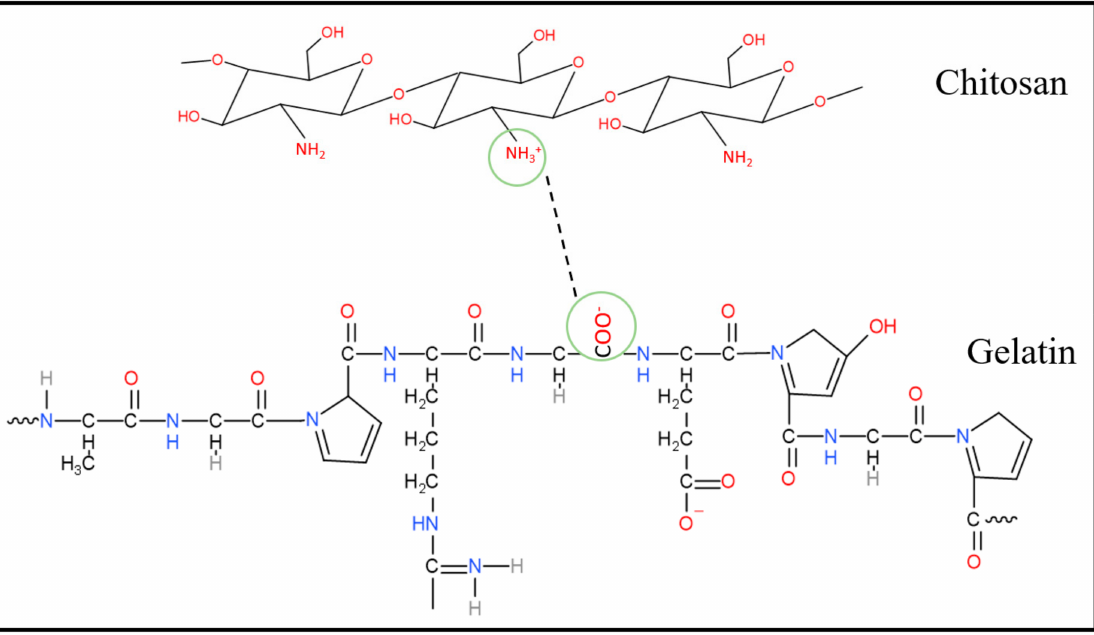
Figure 8. Chemical interaction between the amino group of chitosan and a carboxyl group of